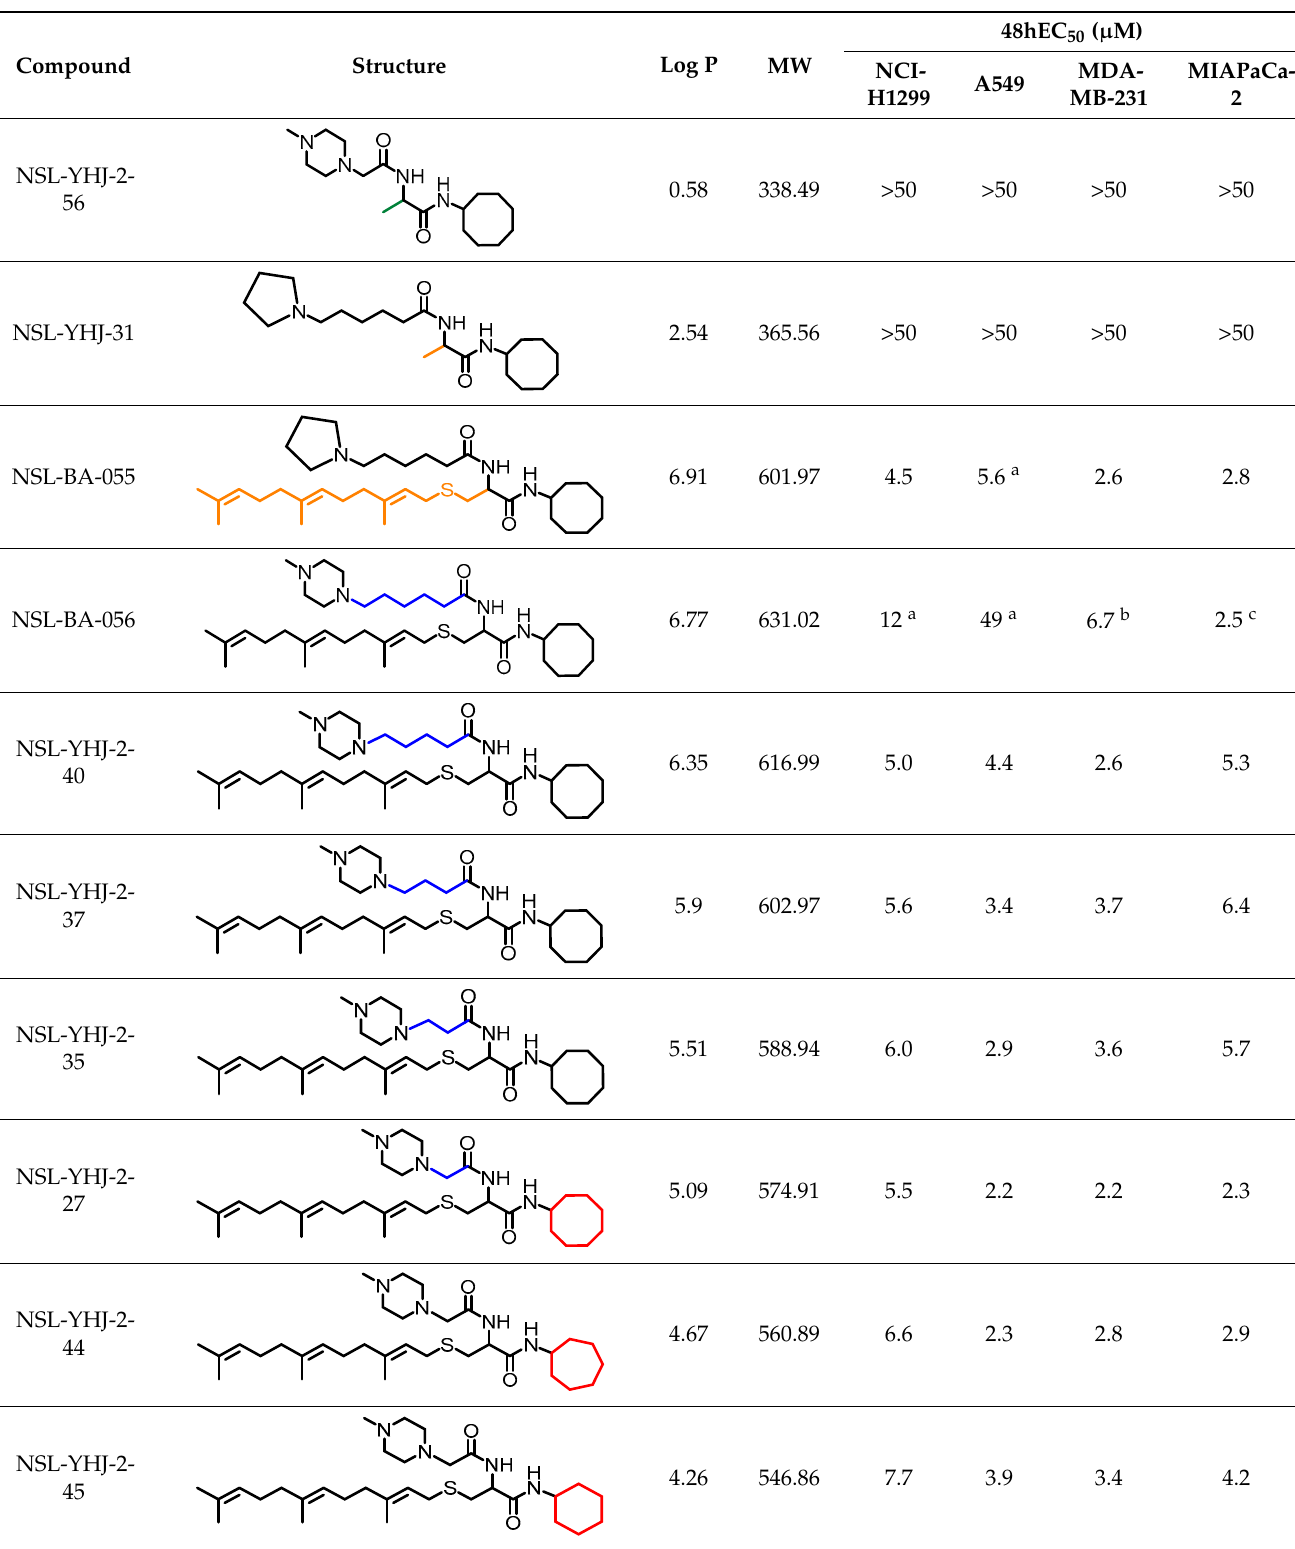
Table 1. Structure activity relationships of the PCAIs. The physicochemical properties and inhibition of cancer cell viabilities by the PCAIs. The EC 50 values were obtained from concentration-response curves following 48 h treatment with the indicated PCAIs. Various structures have been color-coded for easier comparisons.